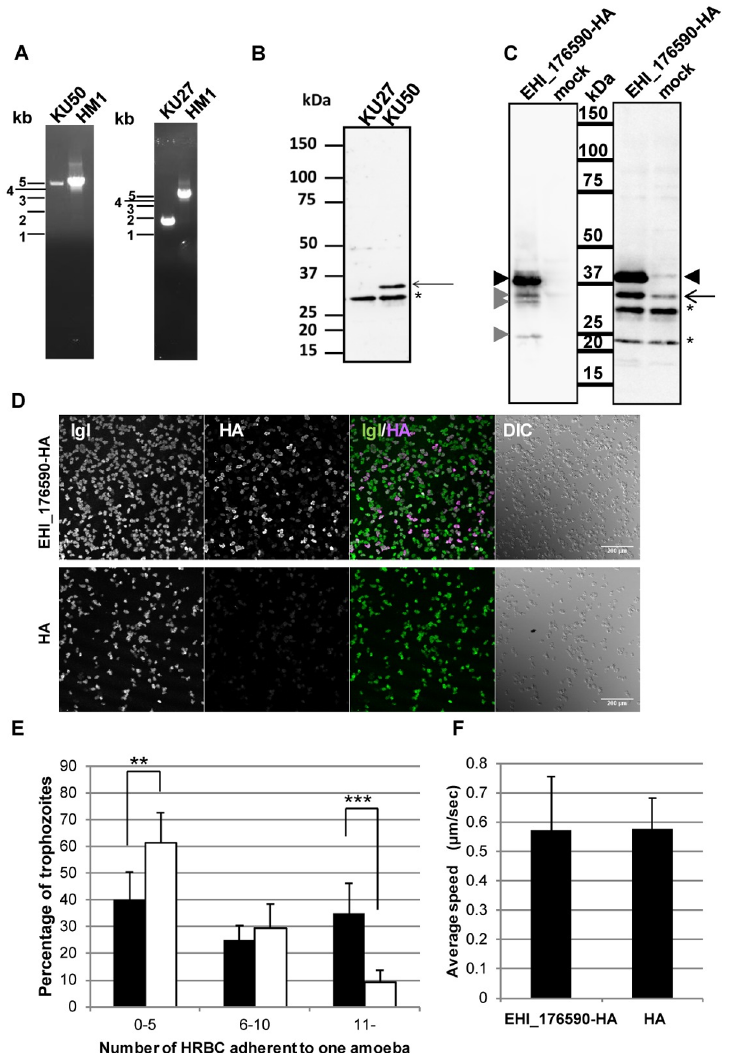
Fig 3. Verification of the loss of EHI_176590 in KU27, overexpression of EHI_176590, and phenotypes caused by EHI_176590 overexpression. (A) Verification by PCR of the lost genomic region, containing the EHI_176590 gene, in KU27. (B) Immuno-detection of EHI_176590 in KU27 and KU50. Total cell lysates, from the indicated strains, were analyzed by immunoblot analysis with anti-EHI_176590 antibody. The arrow depicts the EHI_176590 protein, which is present in KU50, but missing in KU27; asterisk indicates the protein band detected by non-specific binding or cross reaction. (C) Immuno-detection of EHI_176590-HA. Total lysates from EHI_176590-HA-expressing and mock transformants were analyzed by immunoblot analysis with an anti-HA antibody (left panel) or anti-EHI_176590 antibody (right panel). Black arrowheads indicate full-length EHI_176590-HA, and gray arrowheads indicate minor truncated forms of EHI_17690-HA. The arrow indicates intrinsic EHI_176590. Asterisks depict protein bands detected by non-specific binding or cross reaction. (D) Low magnification confocal immunofluorescence images of the EHI_176590-HA-expressing and mock-transfected transformants. Trophozoites were fixed and reacted with anti-Igl and anti-HA antibodies. Merged fluorescent (IGL/HA) and differential interference contrast (DIC) images are also shown. (E) Increased adherence to HRBCs by EHI_176590 overexpression. EHI_176590-HA-expressing (filled bars) and mock (open bars) transformants were co-cultured with HRBCs on ice for 30 min, and the number of adherent HRBCs per ameba were counted. The total number of trophozoites was set to 100% and the percentages of trophozoites, bound to 0–5, 6–10, or > 10 HRBCs, are shown. Error bars indicate standard deviations of four biological replicates (2292 and 1762 trophozoites were counted for the EHI_176590-HA-expressing and mock transformants, respectively). (cid:3)(cid:3) p-value < 0.01, (cid:3)(cid:3)(cid:3) p-value < 0.001 (F) Cell motility of the EHI_176590-HA-expressing and mock- transfected transformants. Time-lapse images of CellTracker Green-loaded EHI_176590-HA-expressing and mock (“HA”) transformants were analyzed by ICY software to measure cell motility. The average speed and standard deviation of the motility of EHI_176590-HA and mock vector transformants (HA) are shown; 135 and 106 trophozoites, respectively, were monitored in four independent experiments.